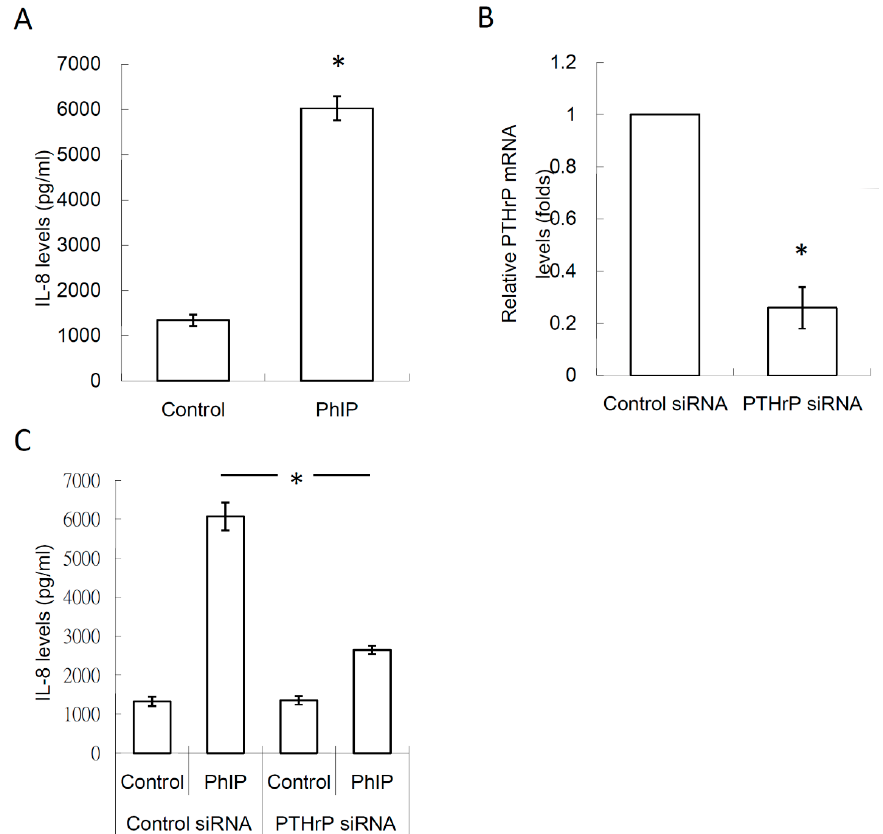
Figure 4. PhIP increased IL-8 production through PTHrP-mediated mechanism in 786-O. ( A )